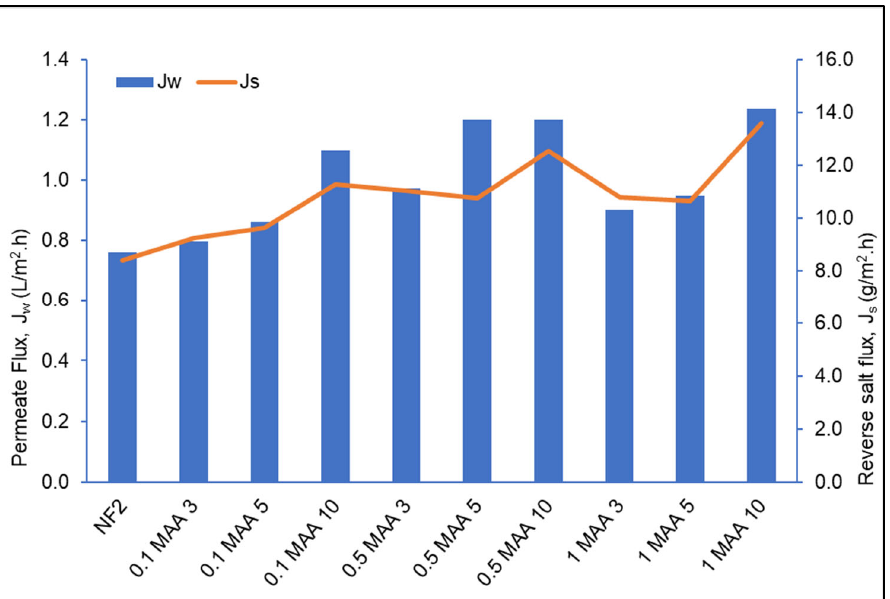
Figure 13. Water permeate flux (J w ) and reverse salt flux (J s ) of the unmodified NF2 PES membrane and the UV − grafted membranes under different modification conditions, with 1 M NaCl draw solution and DI water as feed.